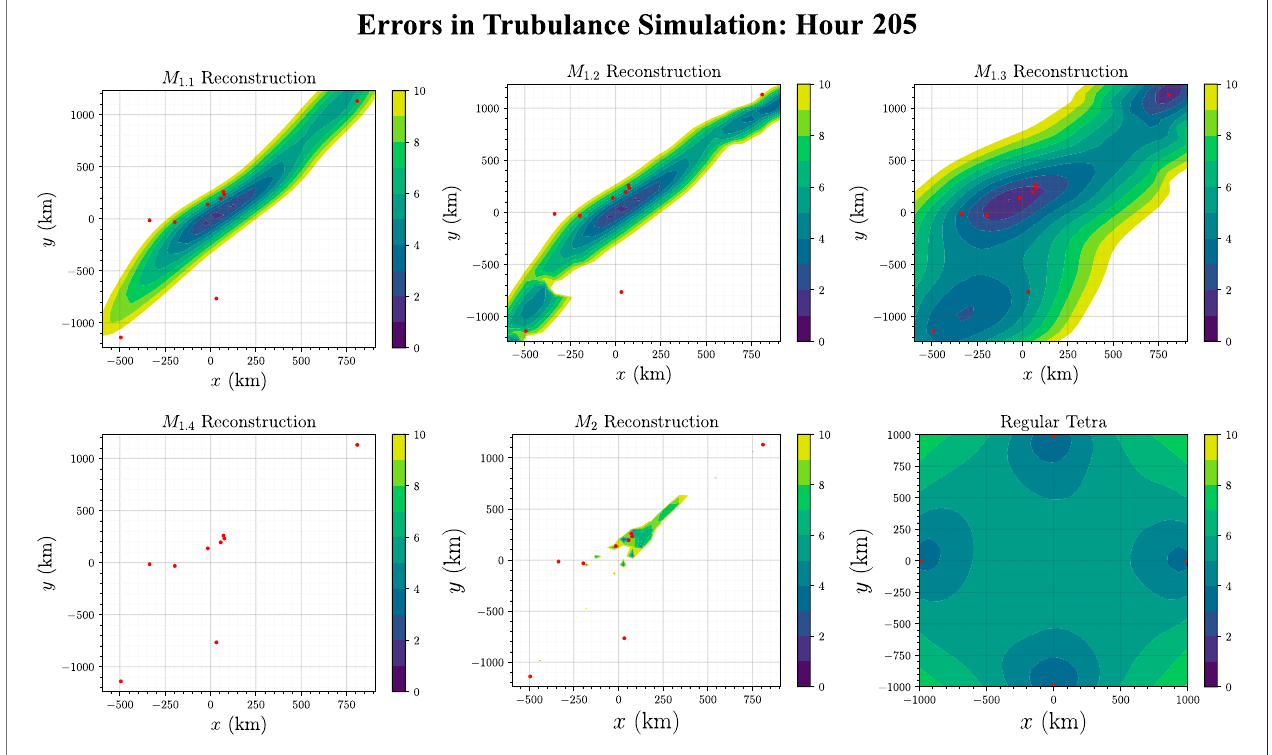
FIGURE 10 | Computation error (de fi ned in Eq. 7 ) at all points on the z (cid:1) 0 plane of the turbulent magnetic fi eld (from the Gkeyll Simulation), using the swarm con fi guration at hour 205 of the HelioSwarm DRM. The layout is identical to Figure 4